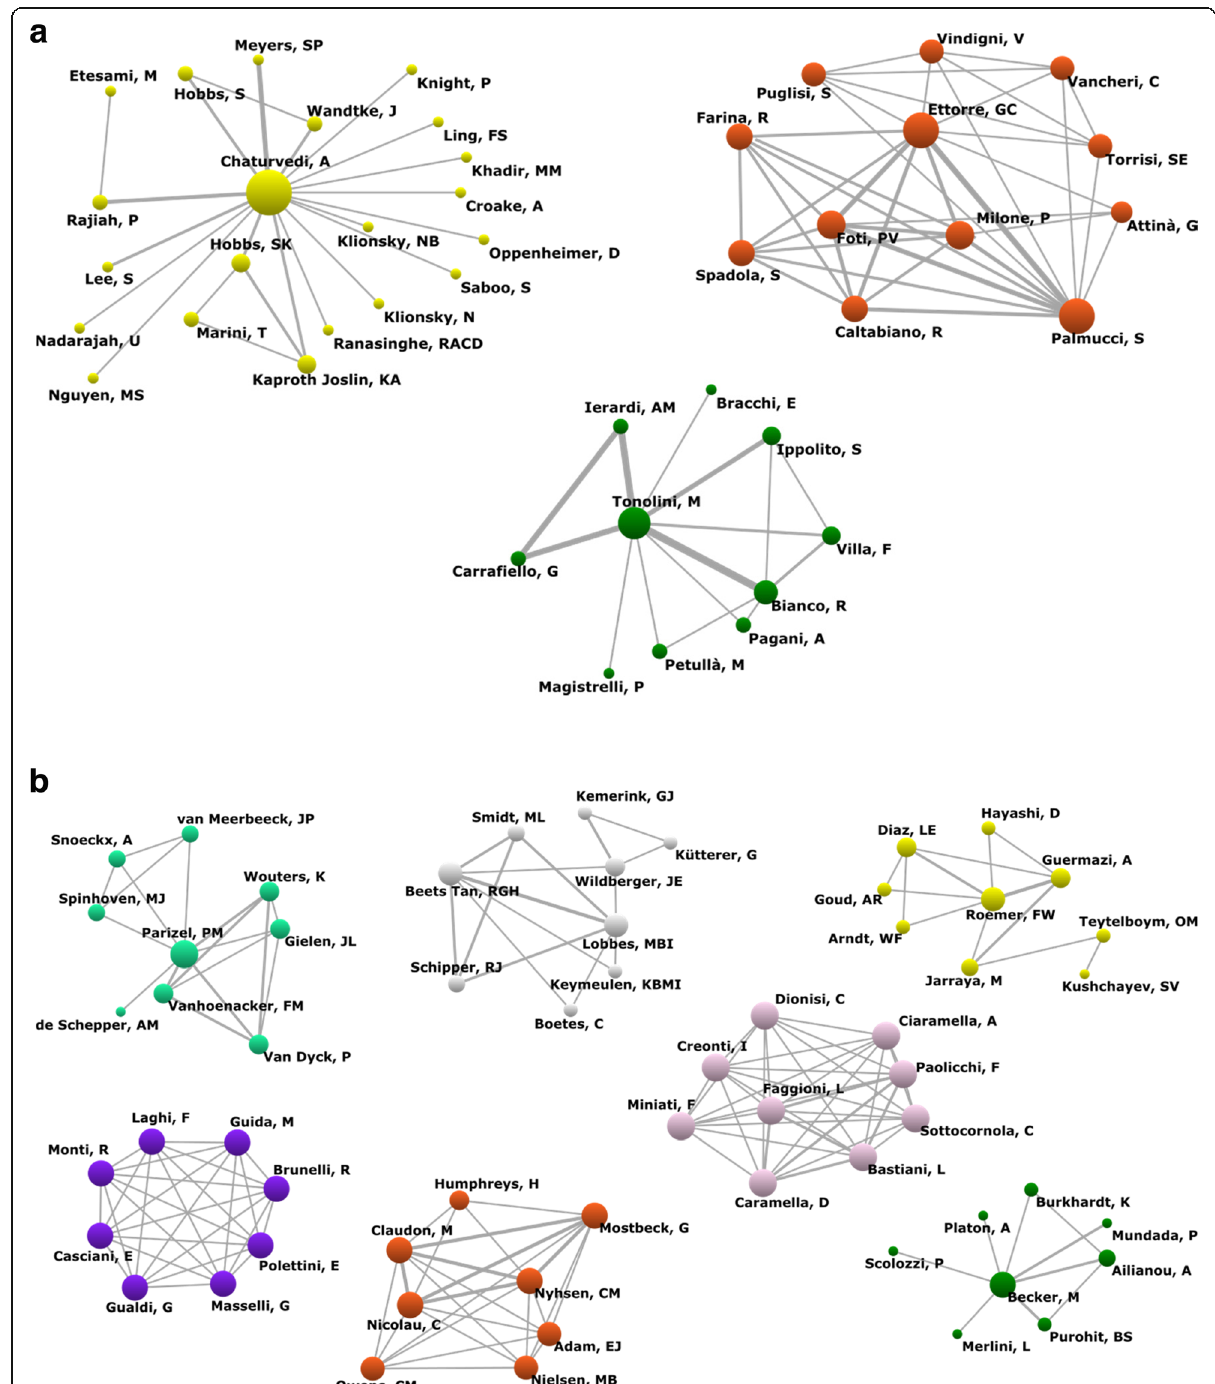
Fig. 3 Network of collaboration between authors. a Groups of 21, 12, and 10 authors. b Groups with 9 or 8 members (source: Scopus